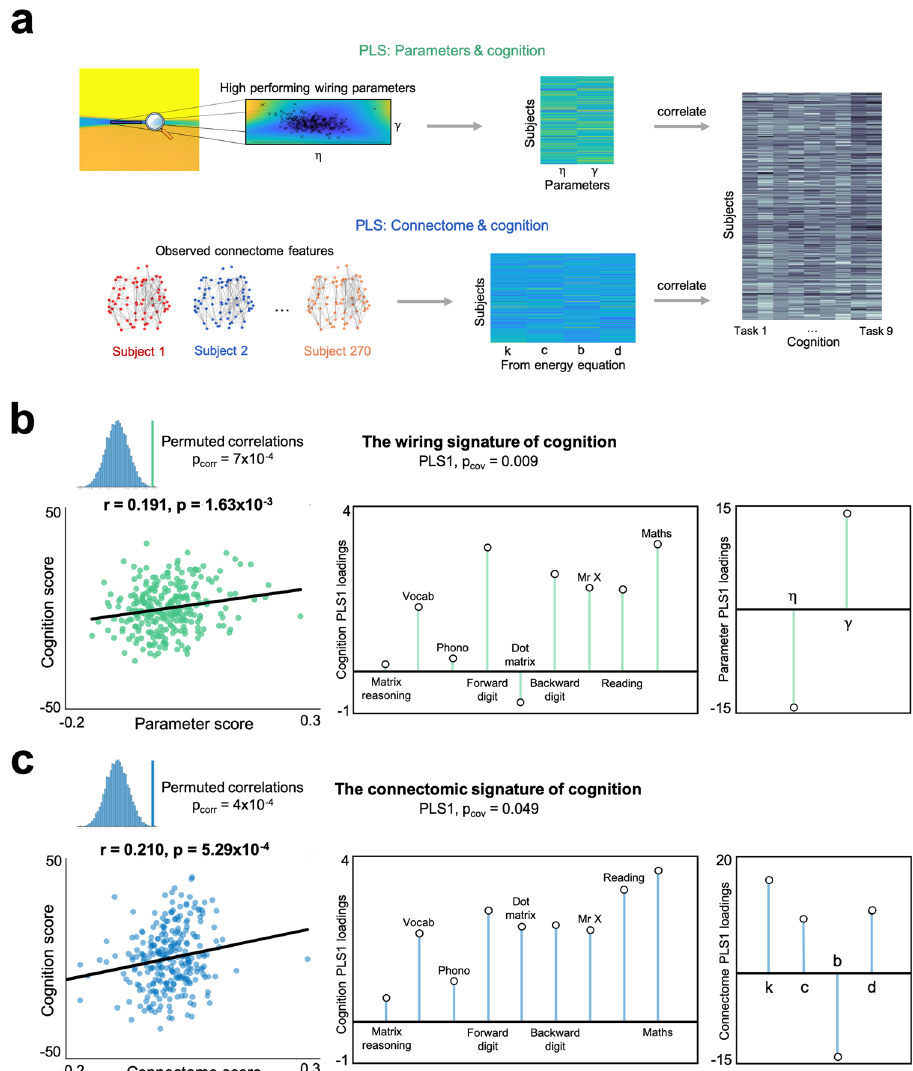
Fig. 5 Covarying patterns of wiring parameters and connectome features with cognitive performance across nine cognitive tasks. a A visual representation of the two PLS analyses undertaken. b There is a signi fi cant positive correlation (two-tailed linear correlation, quoting the Pearson ’ s correlation coef fi cient) between parameter scores and PLS-derived cognitive scores. PLS1 was statistically signi fi cant ( p corr = 7 × 10 − 4 and p corr = 4 × 10 − 4 , respectively) for both analyses using n = 10,000 permutations. Each parameter loads with similar magnitude onto PLS1. c There is an analogous signi fi cant positive correlation between connectome scores and PLS-derived cognition scores, using the same statistical